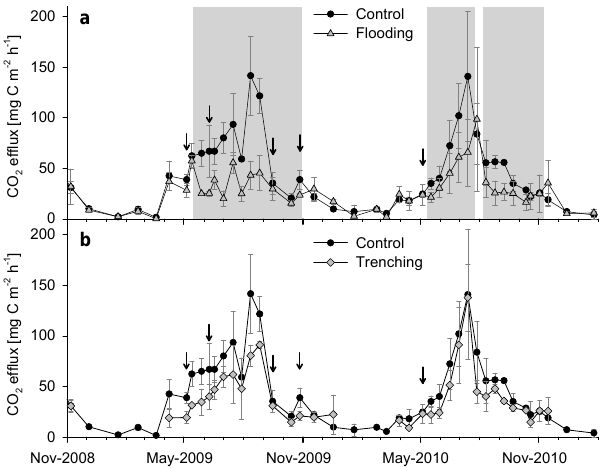
Fig. 3. Soil CO 2 effluxes in (a) control and flooded plots and (b) in control plots and trenched subplots. Error bars represent the standard deviation of the mean (SD). Shaded areas mark the periods of experimental flooding with an interruption for technical reasons at the end of July 2010. Arrows point to dates of radiocarbon sampling.